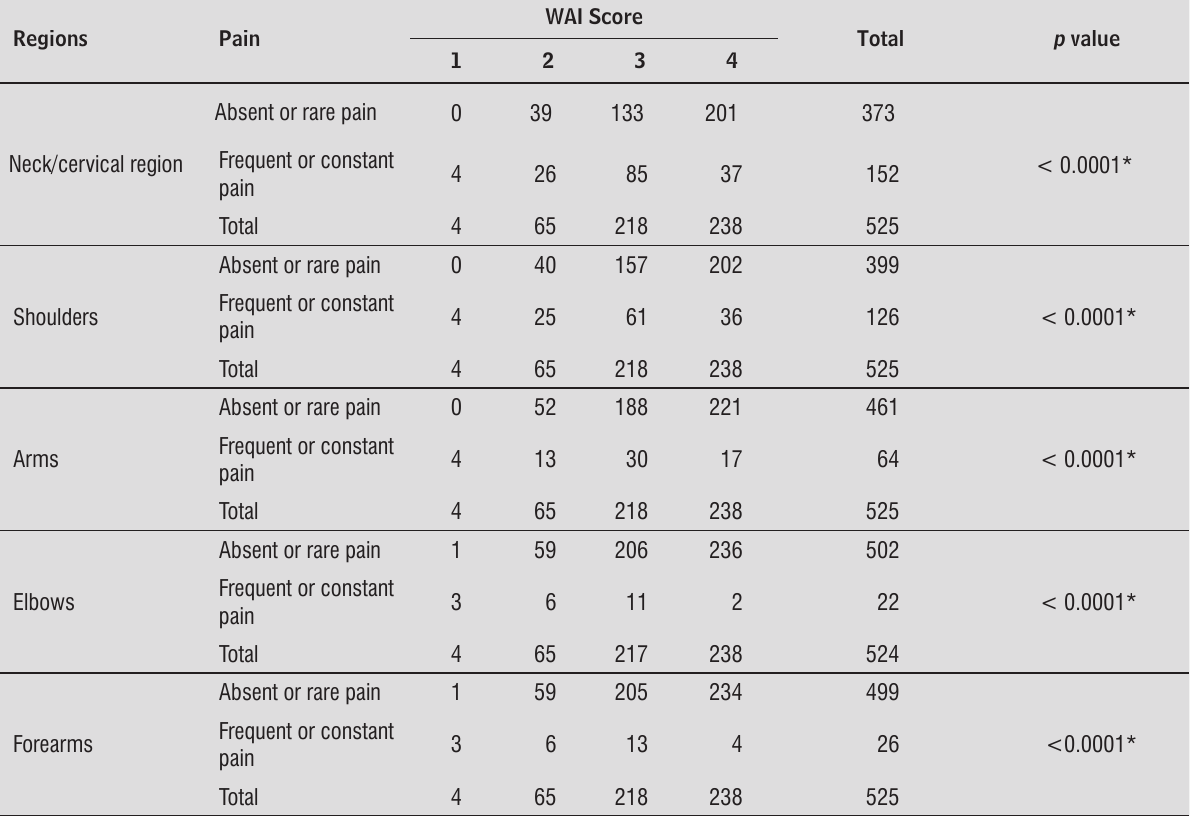
Table 2 - WAI score and presence of pain among Unifal-MG staff (Campus I, Alfenas, Minas Gerais, Brazil)